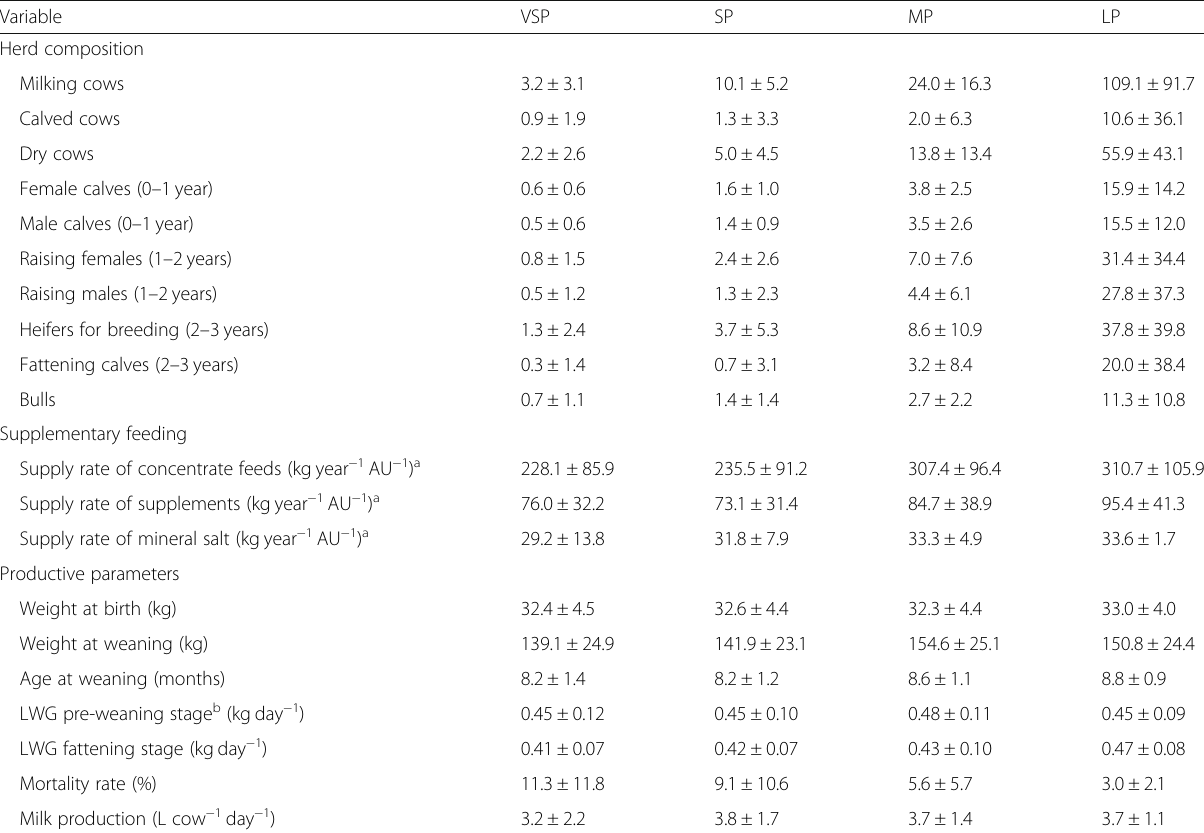
Table 3 Herd composition, supplementary feeding, and productive parameters by farm size for dual-purpose farms (average ± standard